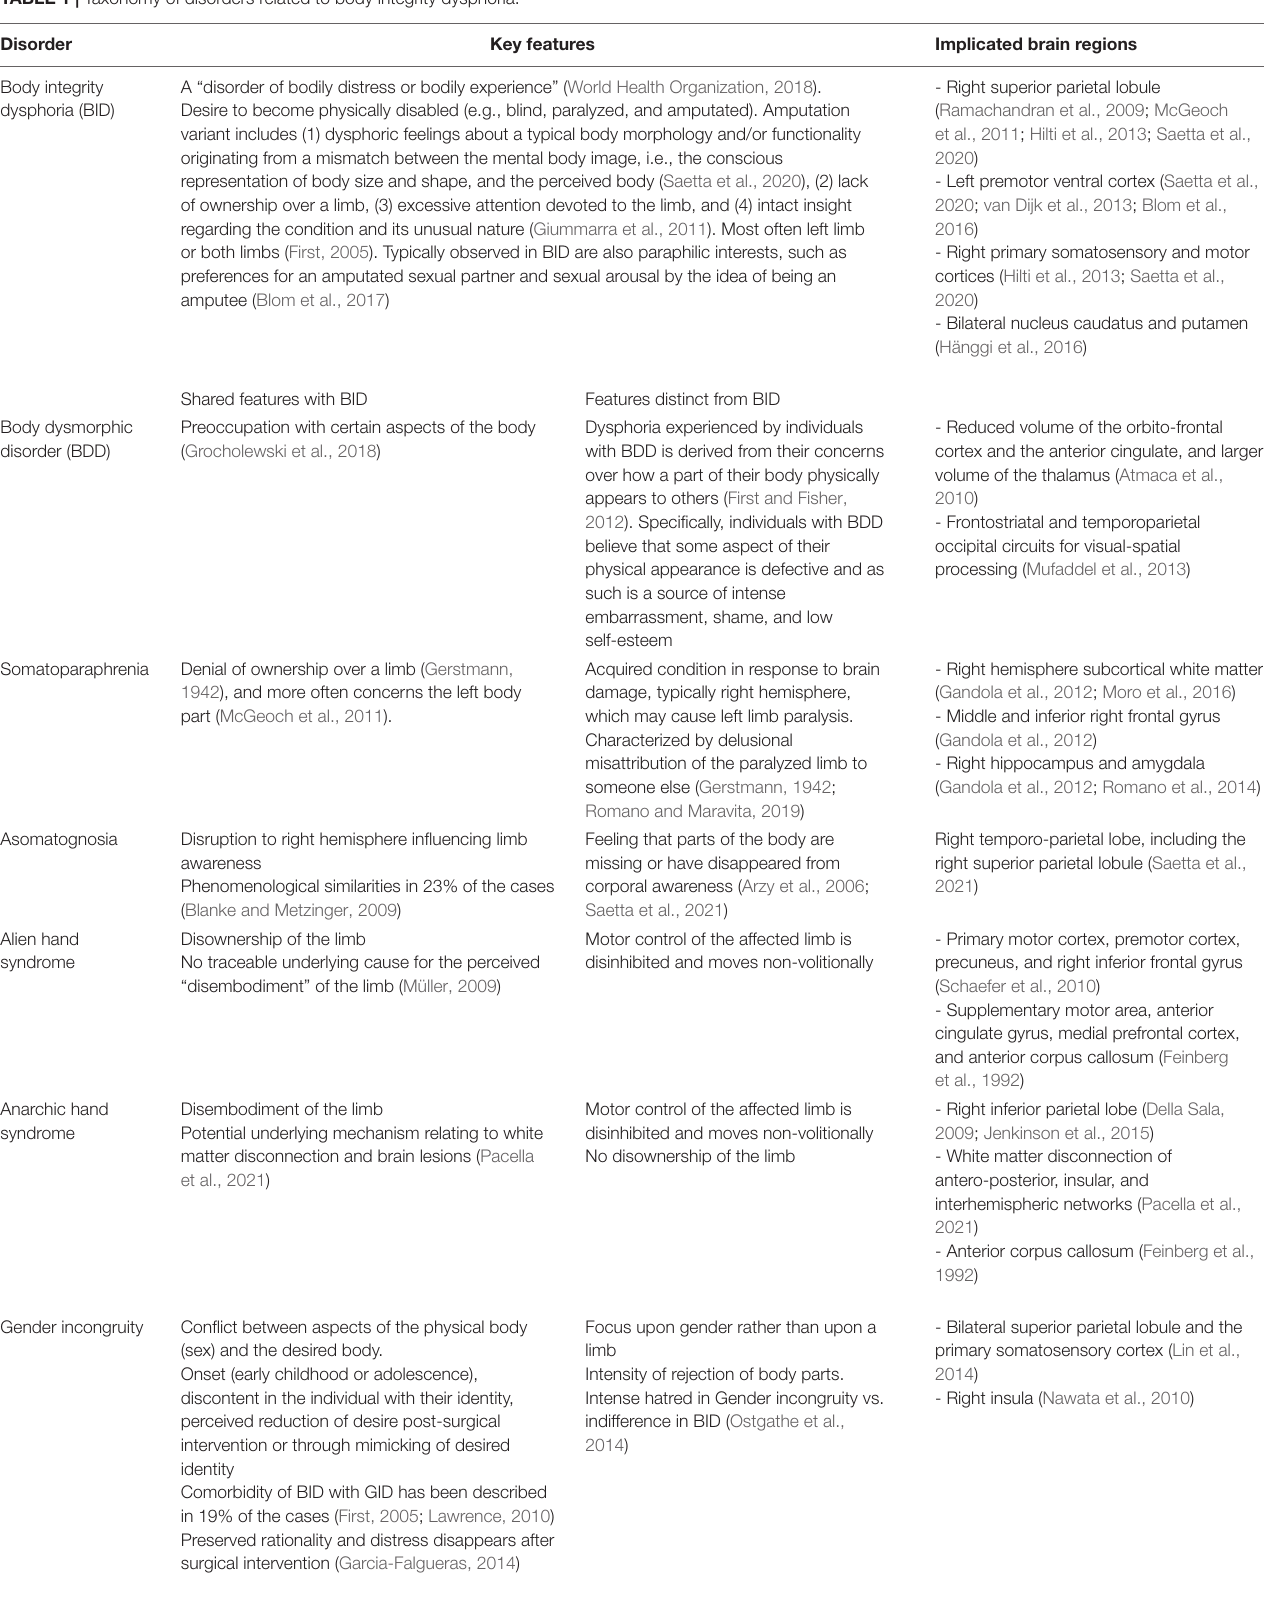
TABLE 1 | Taxonomy of disorders related to body integrity